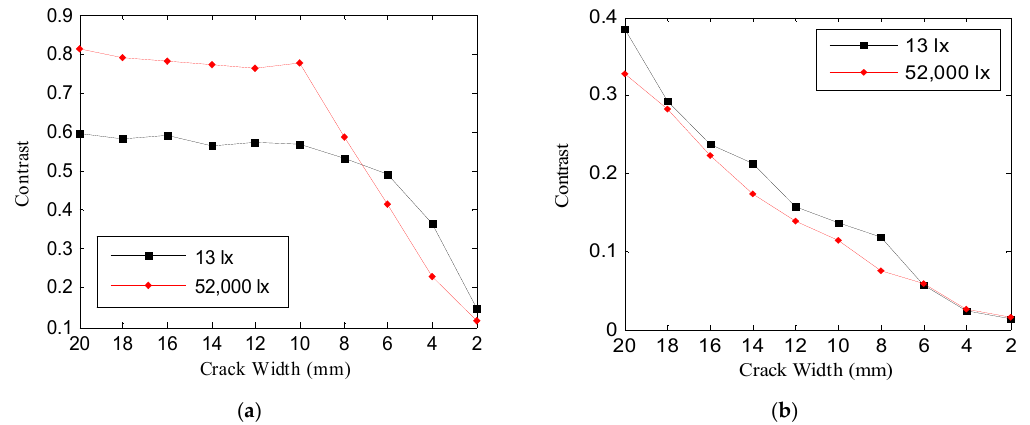
Figure 15. Comparison of contrast of crack images acquired at 13 lx and 52,000 lx, Image acquisition distance: ( a ) 25 m, ( b ) 100 m.